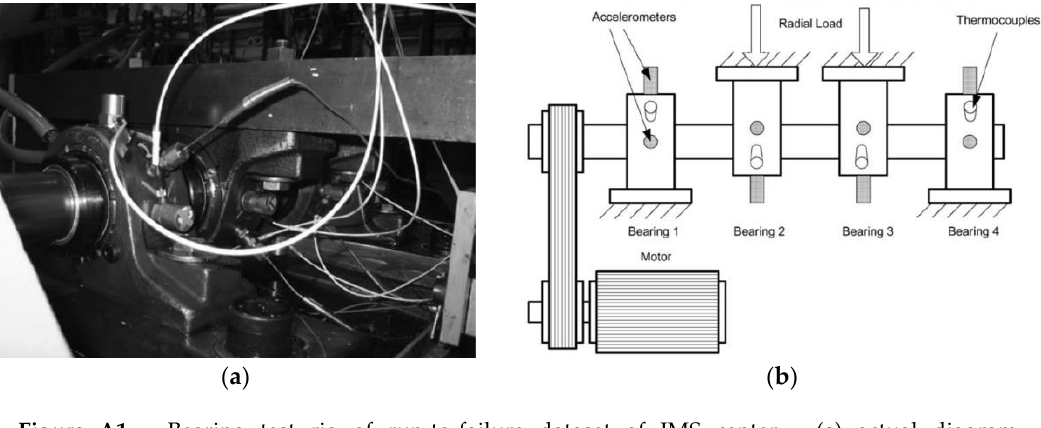
Figure A1. Bearing test rig of run-to-failure dataset of IMS center. ( a ) actual diagram ( b ) schematic diagram. Dataset II: The Run-To-Faliure dataset of IEEE PHM 2012 Prognostics Challenge